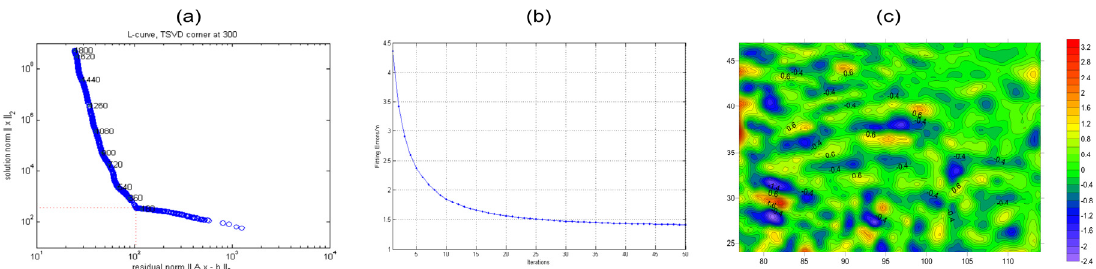
Figure 4. ( a ) L-curve; ( b ) the fitting error decreasing with the number of iterations; and ( c ) the final residual geoid anomaly (m).